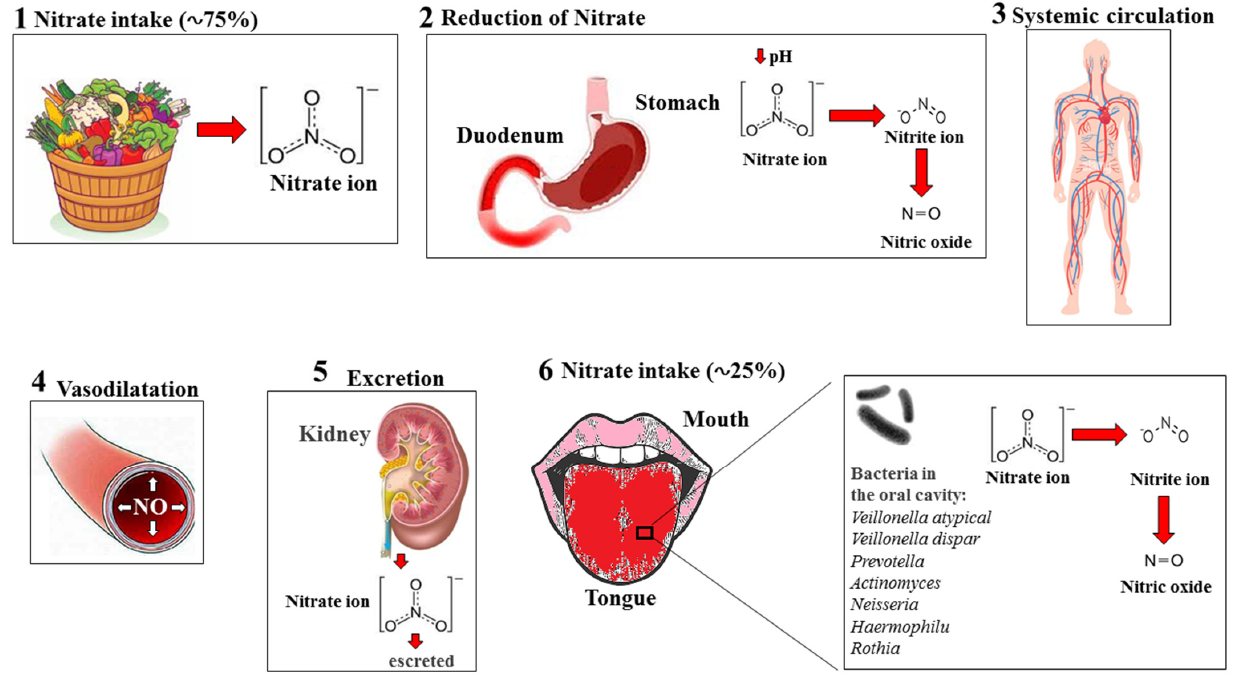
Figure 4. Processing of exogenous nitrates from food. Following exogenous dietary intake ( 1 ), most NO 3- ions are absorbed by the stomach and duodenum. Furthermore, they undergo reduction reactions, stimulated by low pH values in these regions, which also leads to the formation of NO 2 − and NO ( 2 ). Subsequently, the nitrogen compounds are absorbed by systemic circulation ( 3 ), where there follows an increase in NO production and vasodilation ( 4 ). Finally, NO 3 − is normally excreted in the urine by the kidneys ( 5 ). In addition, a component of nitrates, concentrated in the salivary glands, undergoes a reduction induced by bacteria in the oral cavity and is transformed into nitrite and NO ( 6 ).